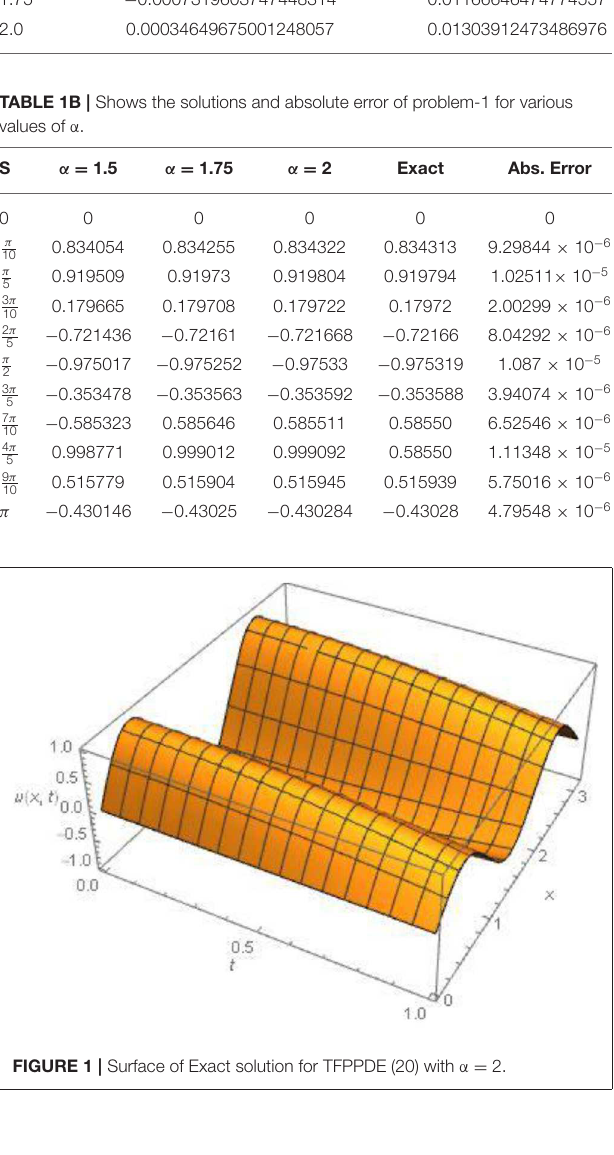
consistent validity. In the above discussion ( Tables 1B , 2B ) show an excellent agreement between the approximate and exact